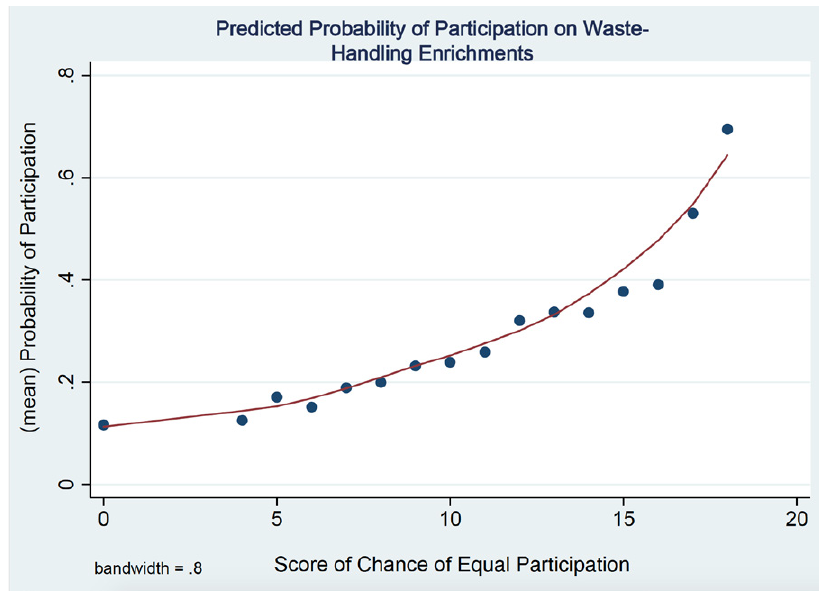
Fig. 3: Higher chance of equal participation given to women will be followed by higher participation rate in waste-handling activities